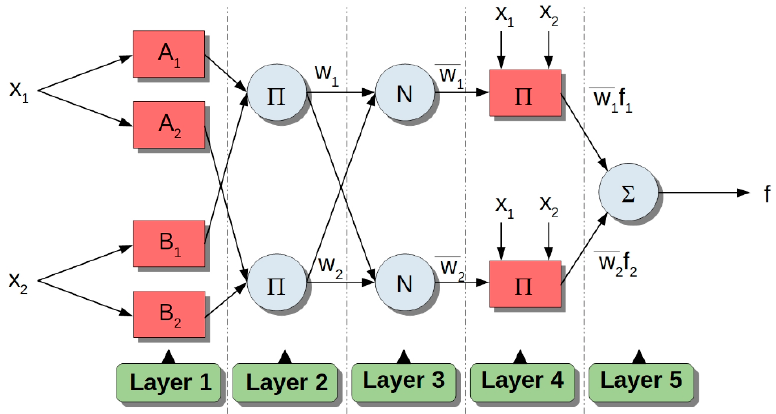
Figure 7. Adaptive neuro-fuzzy inference system (ANFIS) architecture.